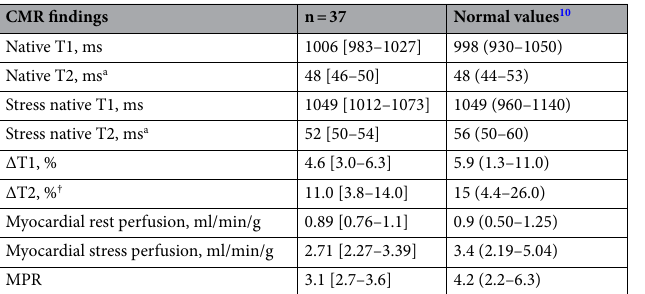
Table 3. Rest and stress findings of the patients. CMR findings are presented as median [IQR]. Reference range was calculated as mean ± 2 standard deviations from 10 . MPR myocardial perfusion reserve. a Data missing for n =